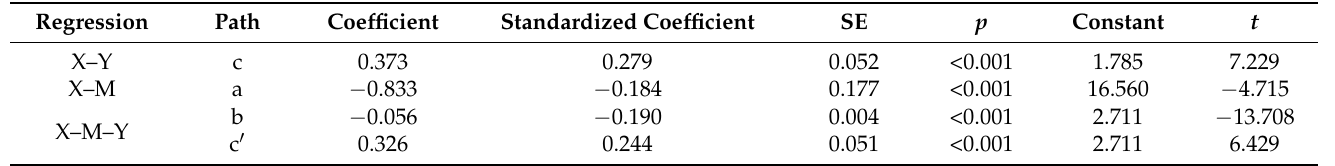
Table 4. Results of causal step regressions.